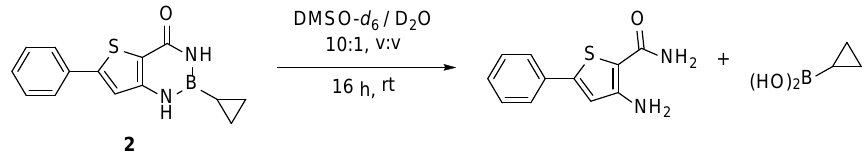
N H Scheme 3. Observed degradation of 2 under neutral aqueous conditions. Scheme 3. Observed degradation of 2 under neutral aqueous